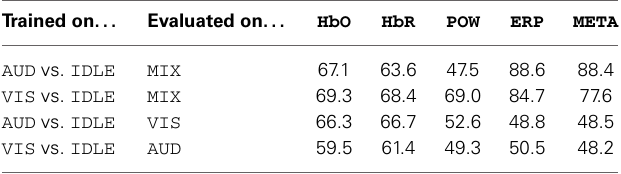
Table 4 | Subject-independent classification accuracy of classifiers (in %) for AUD vs. IDLE and VIS vs. IDLE , evaluated on different trials from outside the respective training set.